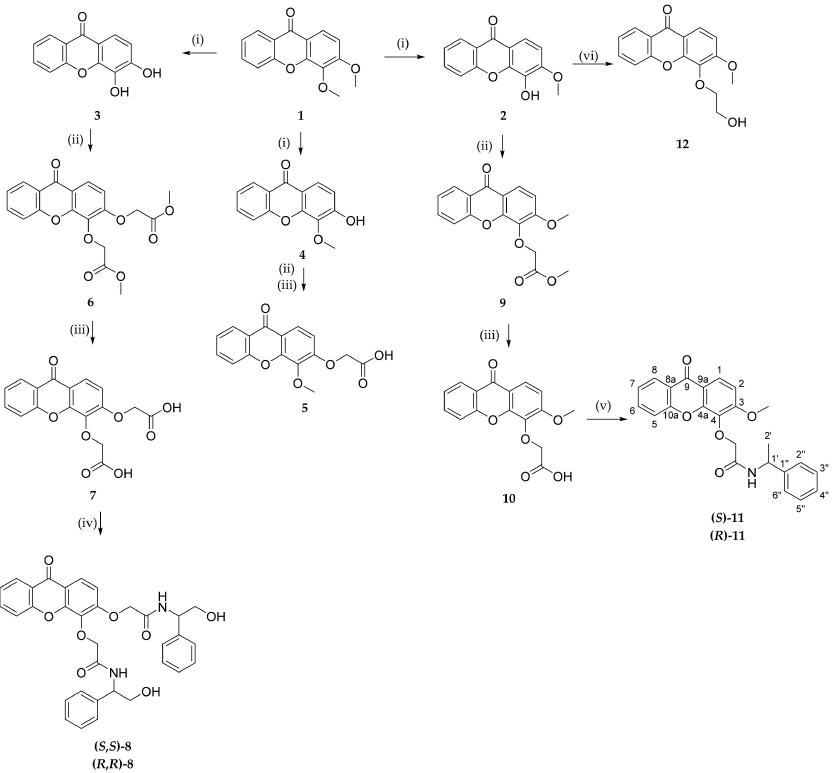
Scheme 1. Synthetic pathways for obtaining 3,4-substituted chiral derivatives of xanthones used in this study. (i) AlCl 3 , anhydrous toluene, 70 ◦ C, 40 min; (ii) BrCH 2 COOCH 3 , K 2 CO 3 , anhydrous acetone, 4–24 h; (iii) NaOH 5M, CH 2 Cl 2 :CH 3 OH